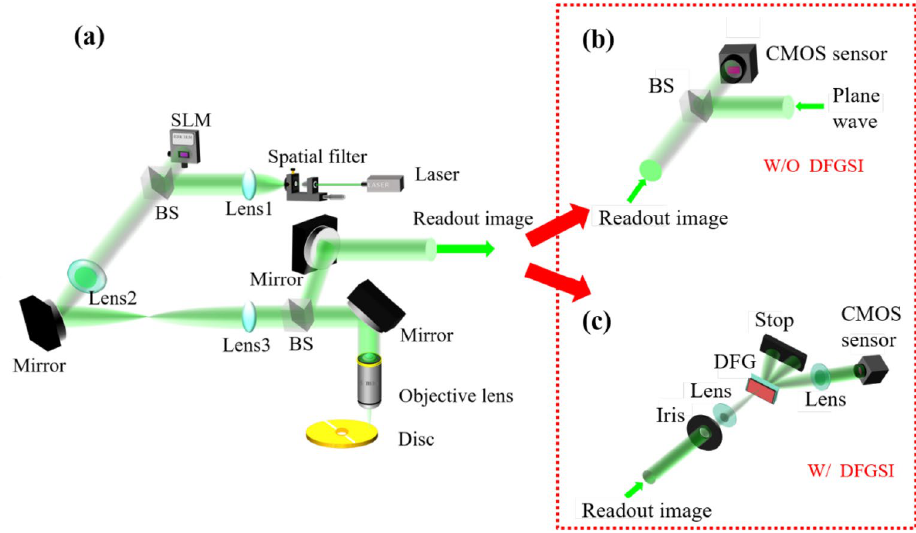
Figure 2. (a) The setup of a holographic data storage system, (b) a general PSI to retrieve the signal phase, and (c) the proposed DFGSI-PSI and spatial light modulator (SLM), which encodes the 2D multi-level